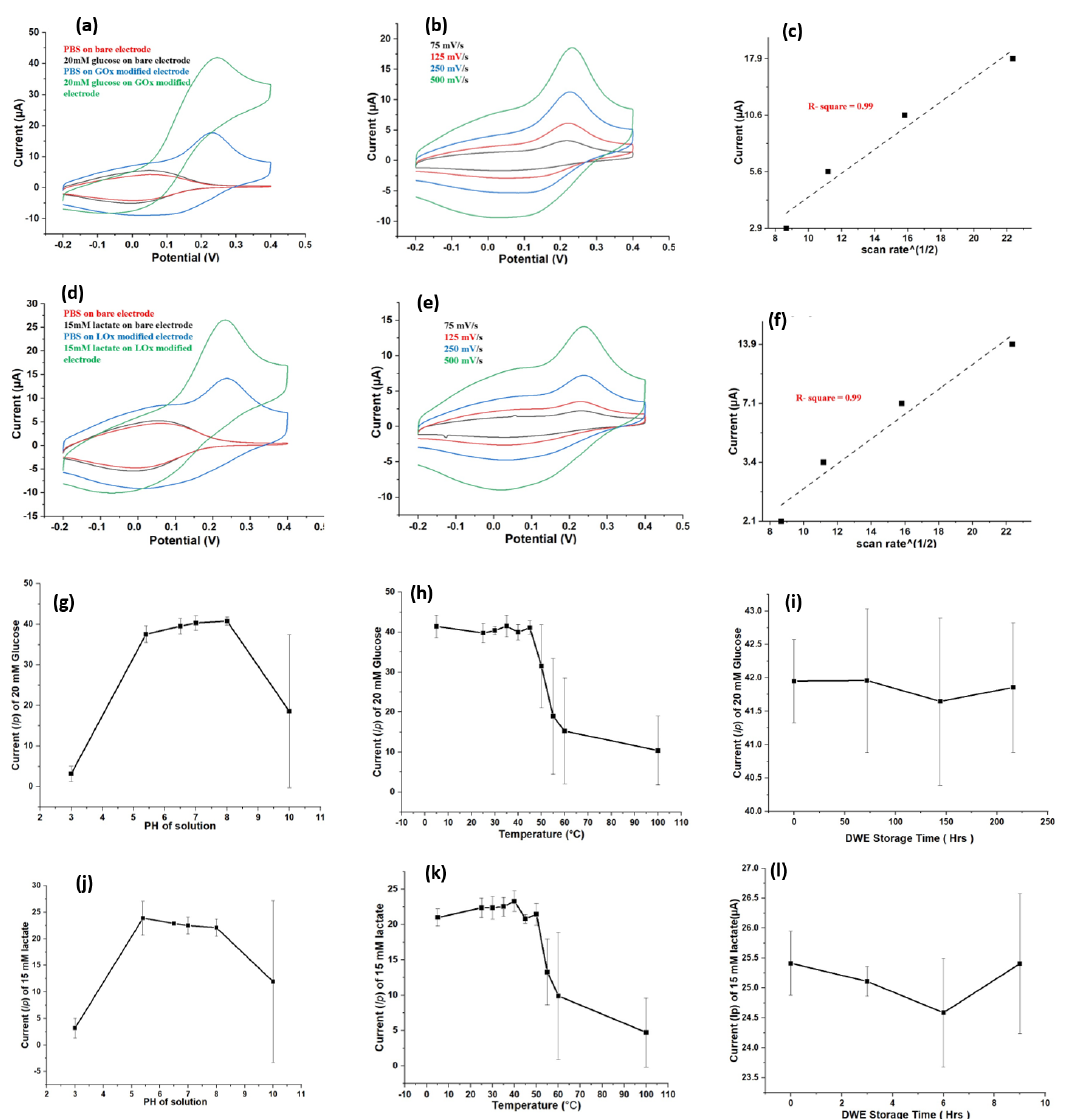
Figure 2. Stability test: ( a ) collective Cyclic voltammetry (CV) responses of a PBS or a 20 mM glucose solution on a bare WE1 or a GOx modified WE1. ( d ) CV responses of PBS or 15 mM lactate solution on a bare WE2 or a LOx-modified WE2. ( b , e ) CV responses PBS on WE1 and WE2 at four different scan rates (75, 125, 250, and 500 mV/s). ( c , f ) Oxidation current peaks, I p , plotted against the scan rates from graphs ( b ) and ( e ). ( g , h ) The I p values of 20 mM glucose measured across a wide pH and temperature range. ( j , k ) the I p values of 15 mM lactate measured across a wide pH and temperature range. ( i , l ) I p values of 20 mM glucose and 15 mM lactate measured after various storage times (0, 72, 144, and 216 h). All experiments are conducted on double working screen-printed carbon electrodes (DWSPCEs).